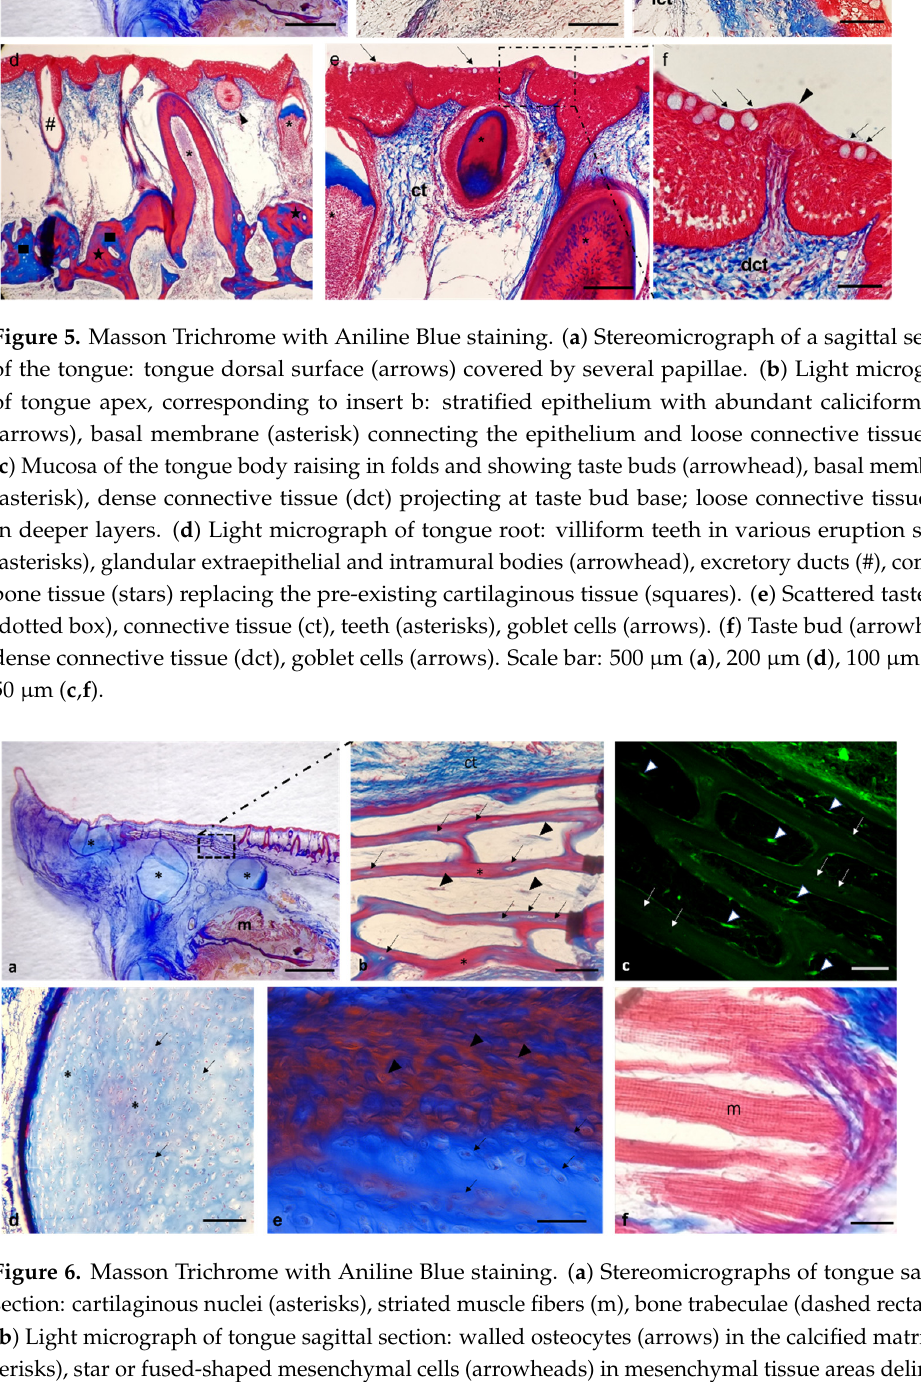
Figure 6. Masson Trichrome with Aniline Blue staining. ( a ) Stereomicrographs of tongue sagittal section: cartilaginous nuclei (asterisks), striated muscle fibers (m), bone trabeculae (dashed rectangle). ( b ) Light micrograph of tongue sagittal section: walled osteocytes (arrows) in the calcified matrix (asterisks), star or fused-shaped mesenchymal cells (arrowheads) in mesenchymal tissue areas delimited by anastomosed bone trabeculae. ( c ) Laser confocal micrograph: vimentin positive cells (arrowheads), osteocytes (arrows). ( d ) Chondrocytes (arrows) immersed in an abundant extracellular matrix (asterisks). ( e ) Ossification front: chondrocytes (arrows) and osteocytes (arrowheads) immersed in the bone matrix ( f ) Striated muscle fibers (m). Scale bar: 500 μ m ( a ), 50 μ m ( b , d – f ), 5 μ m ( c ).